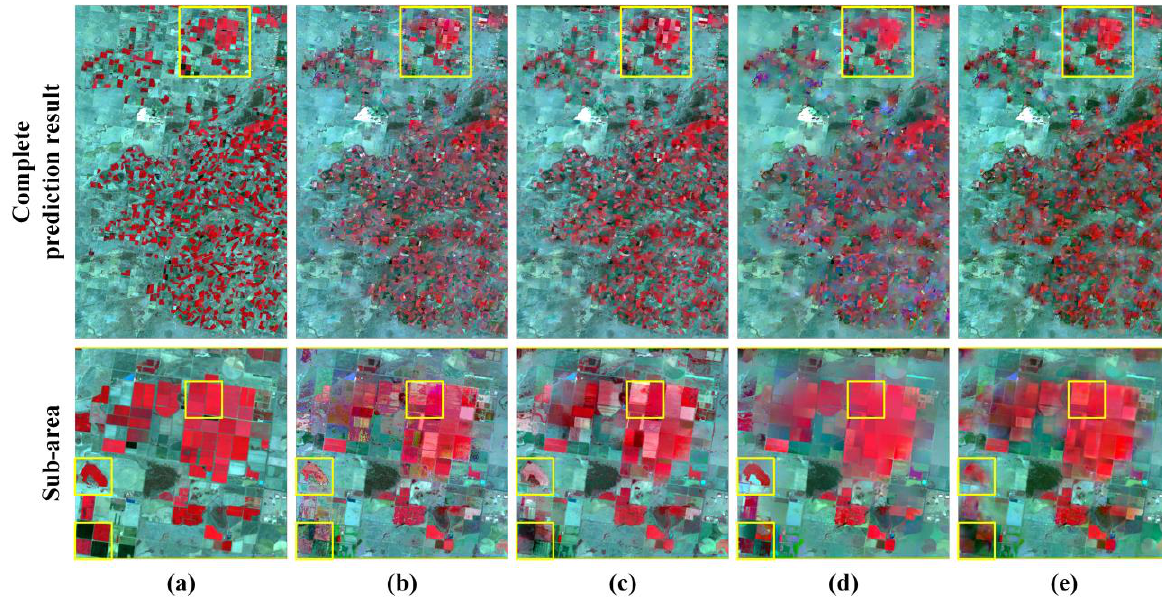
Figure 10 . Visual comparison of the prediction results of different STF methods of the CIA site. ( a ) Actual image. ( b ) STARFM. ( c ) FSDAF. ( d ) Fit-FC. ( e ) HDLSFM. Table 4. Quantitative assessment of the prediction on 13 Feb 2002 of different STF methods in the sub-area of the CIA site. Bold values indicate best results.